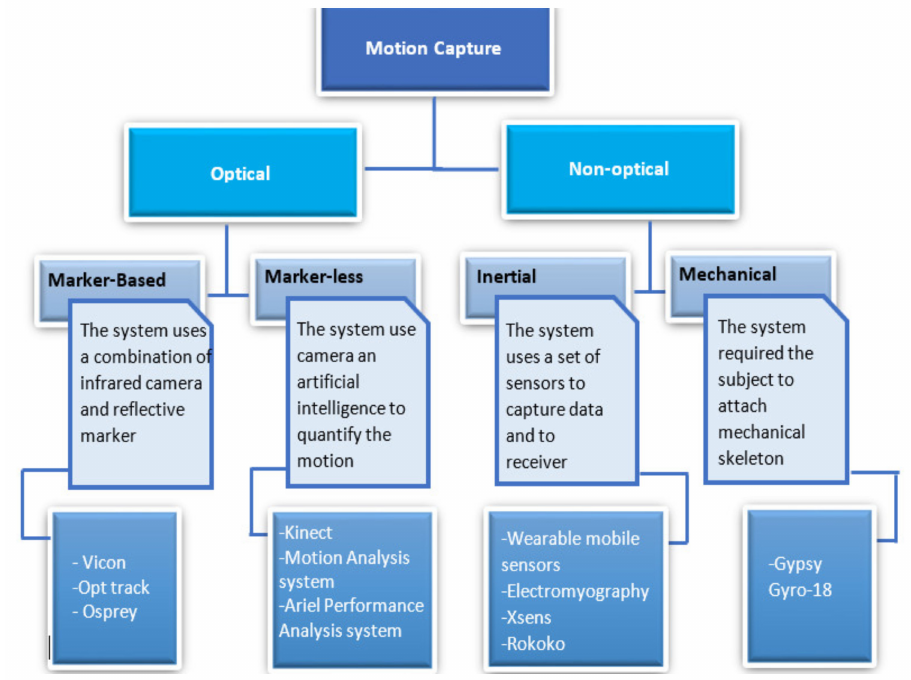
Figure 4. Optical and Non-optical motion capture simulation for ergonomics risk assessment.